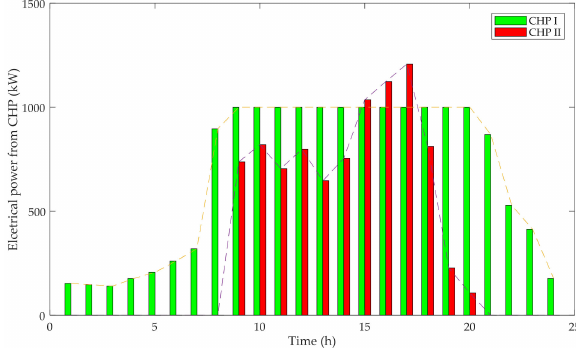
Figure 10. Electrical power supply from CHP_I and CHP_II in Case 1.